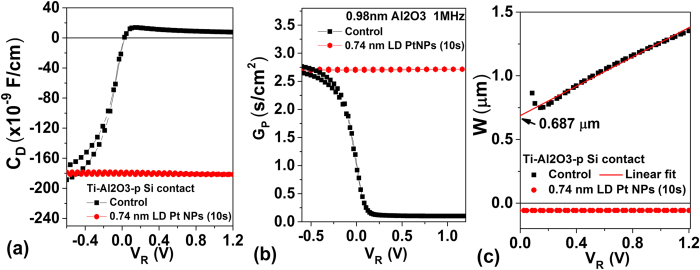
Comparison of (a) CD-V, (b) GP-V, and (c) depletion width Ti-Al2O3-p Si contact with and without 0.74 nm LD Pt NPs (10s).